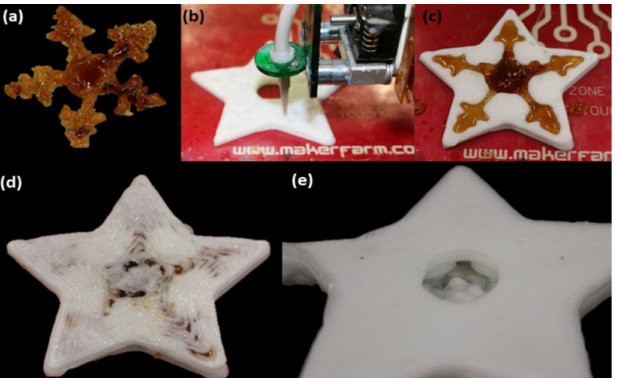
Figure 8. Procedure for printing a silicone structure with hollow channels with carbohydrate glass as support material: ( a ) 3D printed carbohydrate glass, ( b ) 3D printed silicone structure, ( c ) 3D printed carbohydrate glass embedded in the silicone structure, ( d ) printed layer of silicone atop the carbohydrate glass layer, and ( e ) hollow channels after carbohydrate glass dissolving [48]. Reprinted with permission from ref. [48]. Copyright 2021